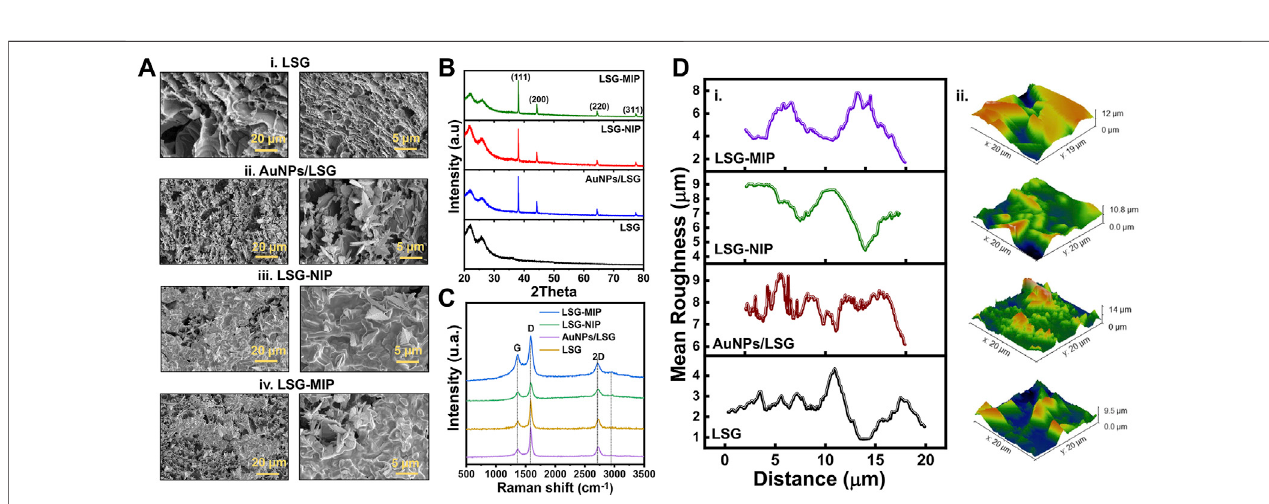
FIGURE3|(A) SEMimages withscalebars of20and 5 µm, (B) XRDspectra, (C) Ramanspectra, and (D) AFM meanroughnessmeasurements and 3Dtopology images of (i) bare LSG, (ii) LSG/AuNPs, (iii) LSG-NIP (LSG-AuNP-PEDOT), (iv) . LSG-molecularly imprinted polymer (MIP) (LSG-AuNP-PEDOT-BPA)